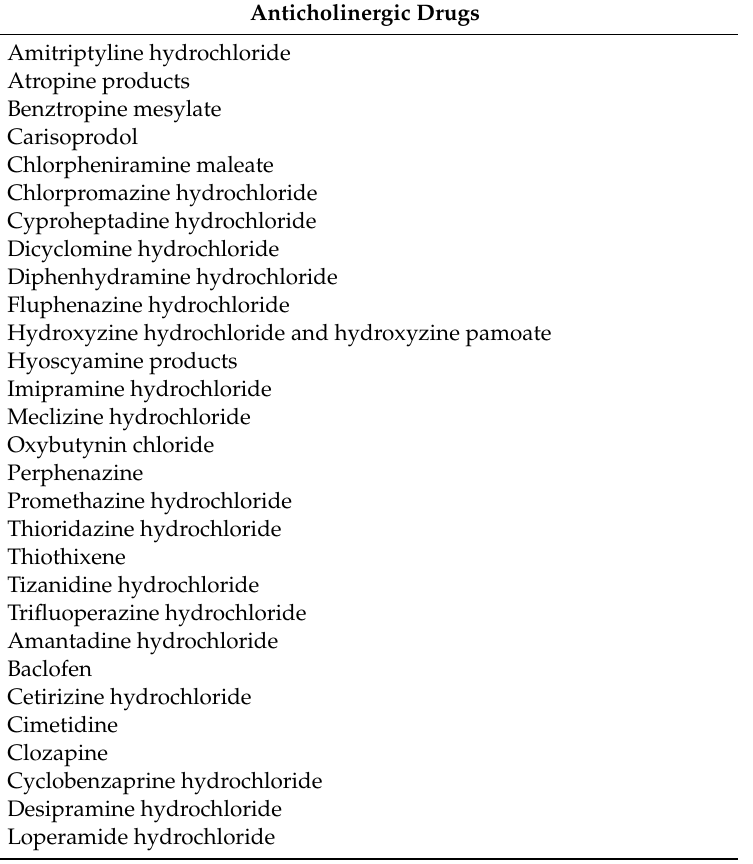
Table A1. The list of anticholinergic